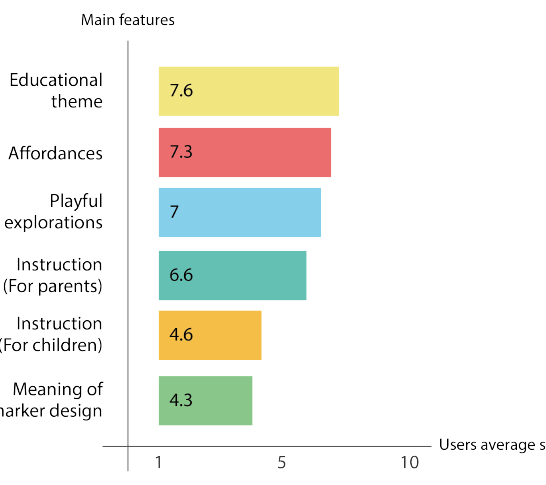
Figure 5. Users’ experience with 5 main